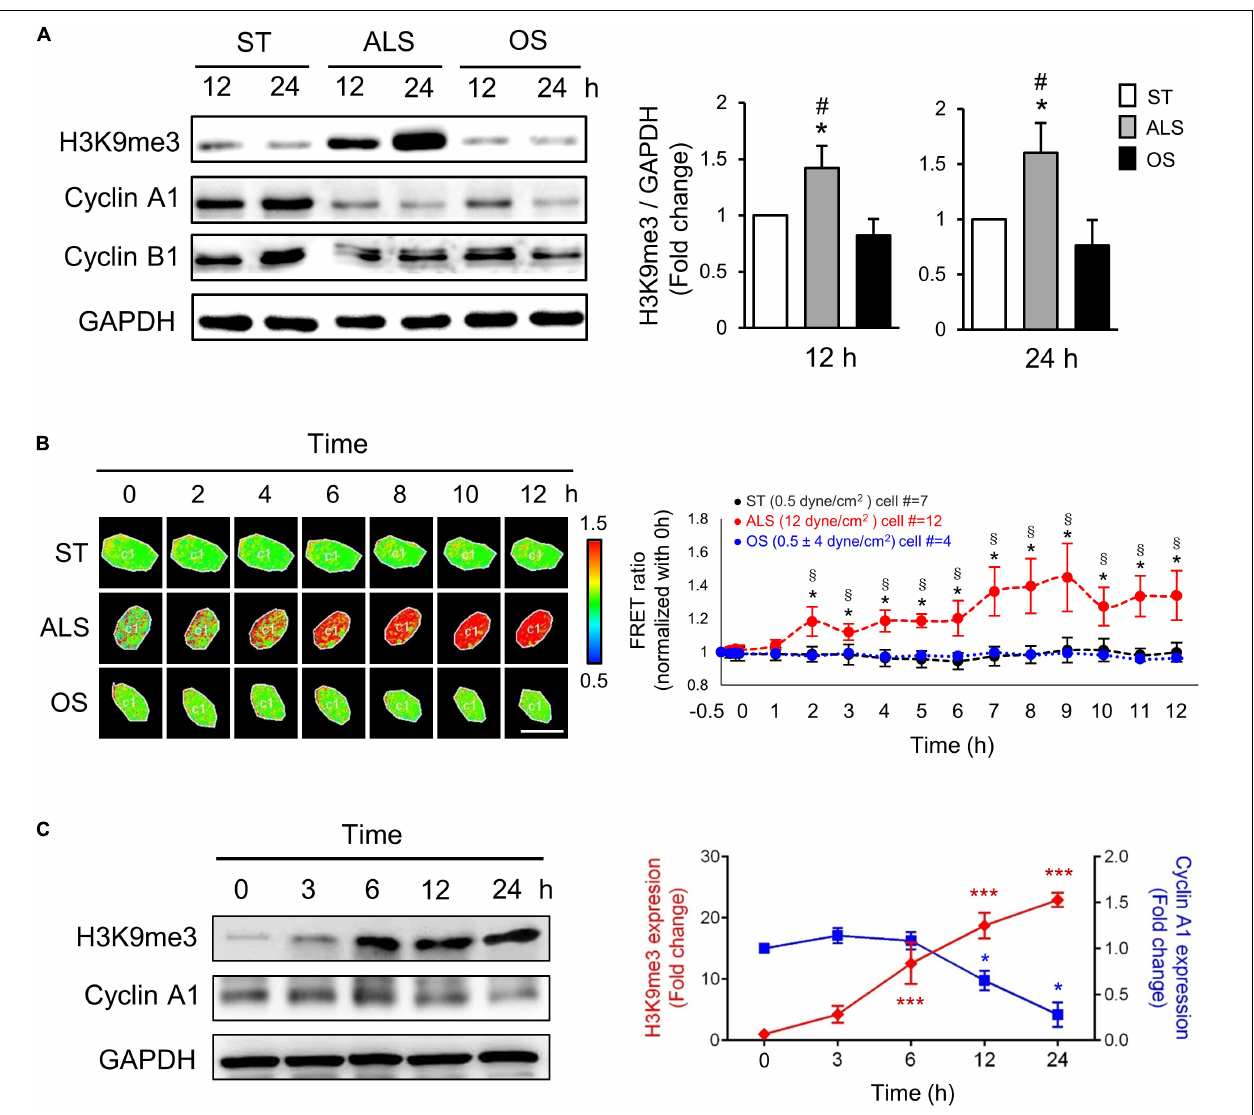
FIGURE 1 | ALS increased the expression of H3K9me3 and promoted the cell quiescence in arterial ECs. (A) Western blotting analysis for the expression of H3K9me3, cyclin A1, and cyclin B1 in HUVECs, which were subjected to ST, ALS, or OS treatment for 12 and 24 h. ALS increased the H3K9me3 expression and decreased the cyclin A1 expression, whereas OS did not change the H3K9me3 at 12 and 24 h. (B) The time-lapse FRET ratio images of arterial ECs expressing the H3K9me3 biosensors were recorded to track the status of H3K9me3 every 2 h under ST, ALS, or OS over the time course of 12 h. The results were normalized to 0 h for each experiment. Scale bar in the phase image: 20 µ m. (C) Western blotting analysis for the expression of H3K9me3 and cyclin A1 in synchronized HUVECs at 0, 3, 6, 12, and 24 h under ALS stimulation. The low expression of cyclin A1 was accompanied by the high level of H3K9me3. Data were represented as mean ± SEM, n = 3. p -values were calculated using one-way ANOVA in (A) and (C) and using two-way ANOVA in (B) with Tukey’s multiple comparisons post-tests. In (A) and (B) , * p < 0.05, ALS-treated HUVECs compared to the ST group; # p < 0.05, ALS-treated HUVECs compared to the OS group. (C) * p < 0.05, *** p < 0.001 with different color indicates a statistically significant difference at each time point compared to their corresponding control group (0